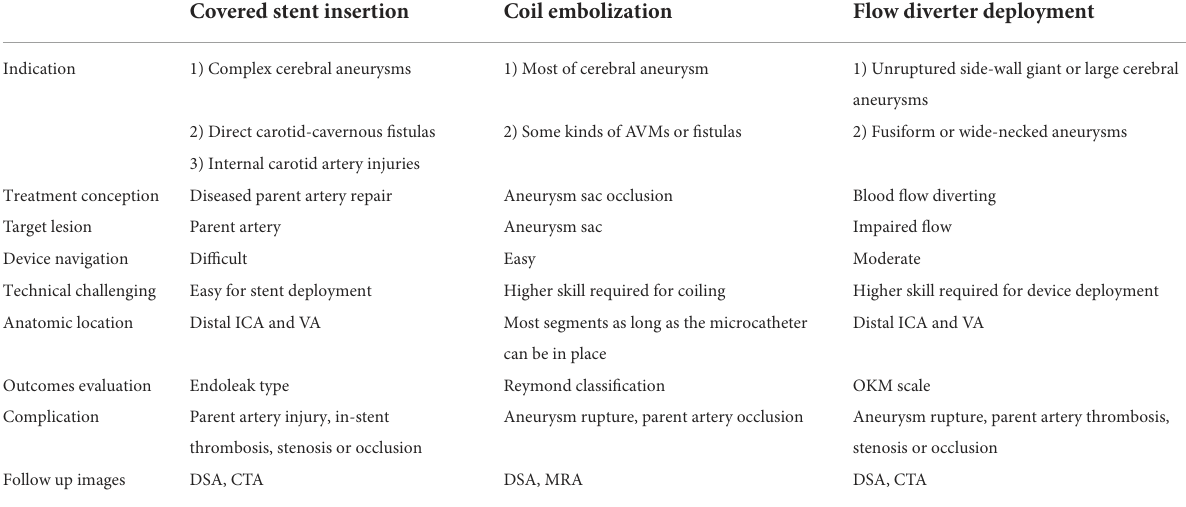
TABLE 1 Comparison of different techniques for endovascular treatment of cerebrovascular